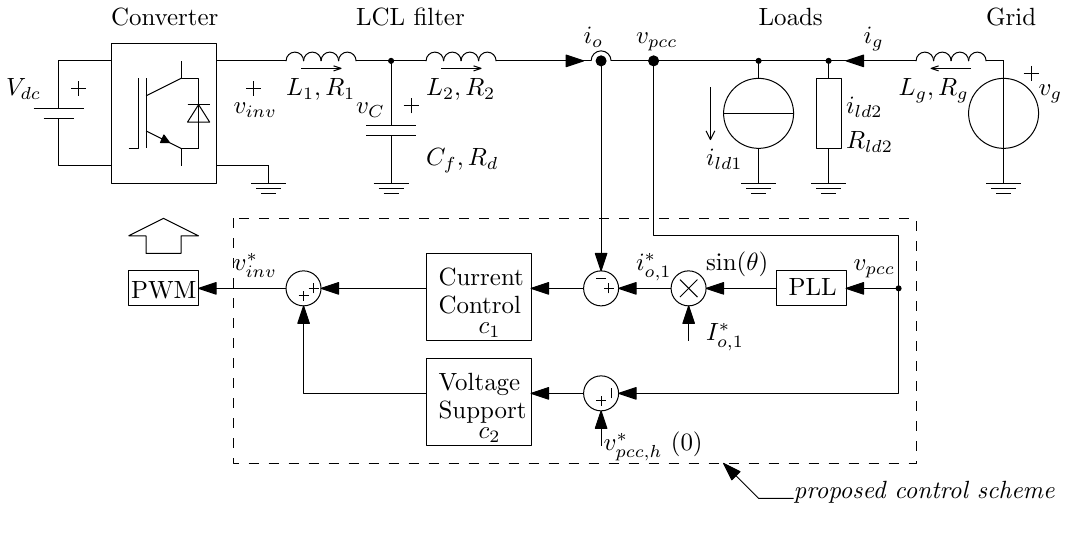
Figure 1. Diagram of the proposed control scheme for a single-phase grid-connected converter